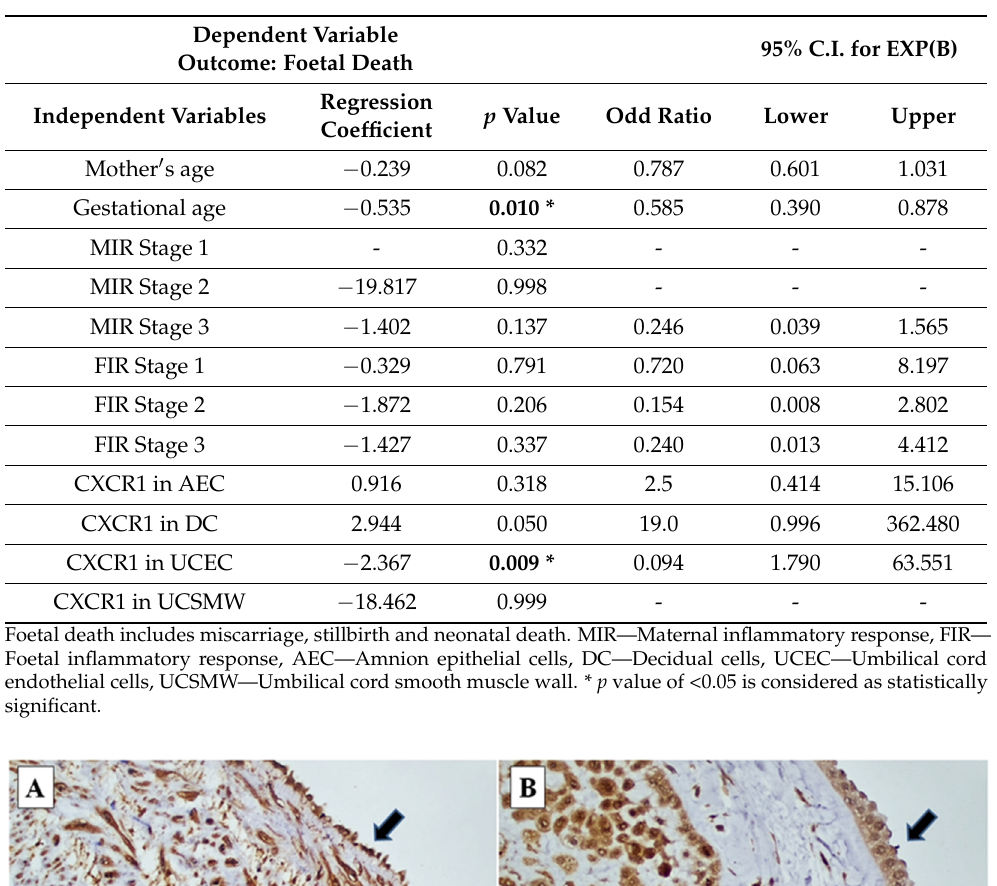
Table 4. Logistic regression analysis with foetal death as the dependent variable against various independent variables in chorioamnionitis.